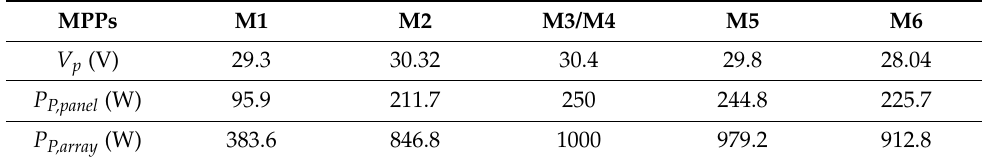
Table 1. Power and Voltage at Maximum Power Points.